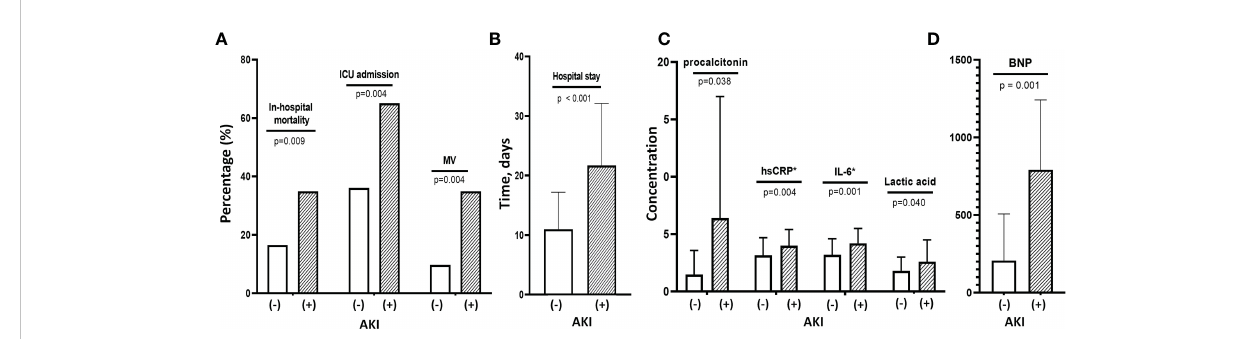
FIGURE 1 Clinical fi ndings and outcomes associated with COVID-19 AKI. (A) Patients with COVID-19 AKI had signi fi cantly higher rates of in-hospital mortality, initial ICU admission and use of MV compared with patients without AKI. (B) These patients with AKI also had longer hospital stays than those without AKI. (C) Baseline levels of in fl ammatory cytokines such as hsCRP, IL-6 and procalcitonin as well as lactic acid levels were signi fi cantly higher in patients with AKI than in those without. (D) They also had higher baseline BNP levels than those without AKI. MV, mechanical ventilation; AKI, acute kidney injury; hsCRP, high-sensitivity C-reactive protein; IL-6, interleukin-6; BNP, B-type natriuretic